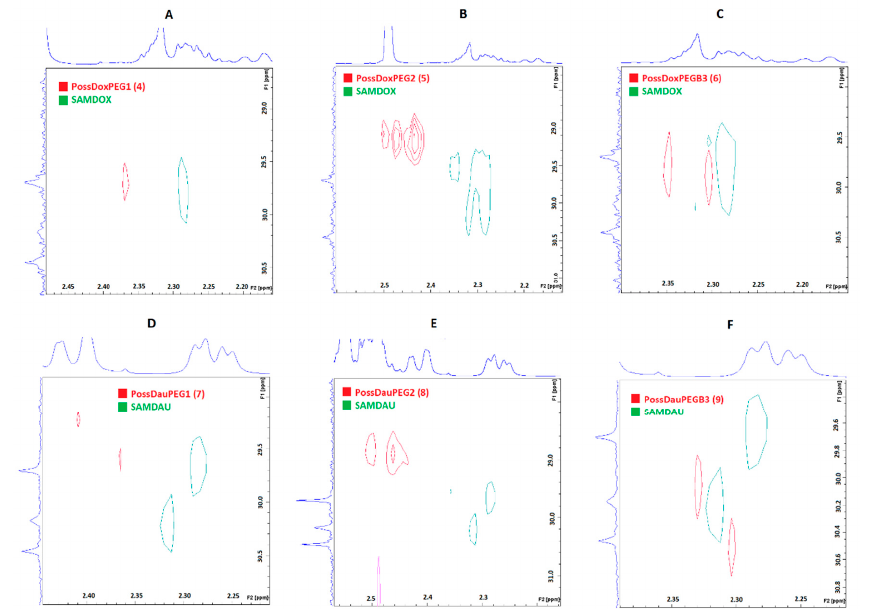
Figure 6. Superimposition of the 1 H- 13 C HSQC spectra of the substrates (SAMDOX/SAMDAU) on the 1 H- 13 C HSQC spectra of the products (conjugates 4 – 9 ). ( A ) PossDoxPEG1 ( 4 ); ( B ) PossDoxPEG2 ( 5 ); ( C ) PossDoxPEGB3 ( 6 ); ( D ) PossDauPEG1 ( 7 ); ( E ) PossDauPEG2 ( 8 ); ( F ) PossDauPEGB3 ( 9 ).